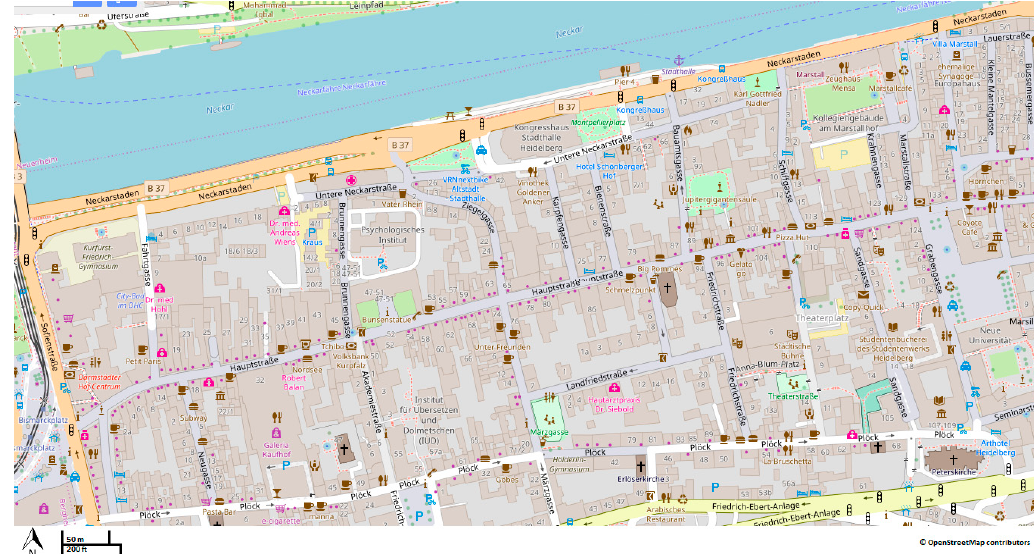
Figure 3. Part of Heidelberg old town where the experiment took place (map: © OpenStreetMap contributors).